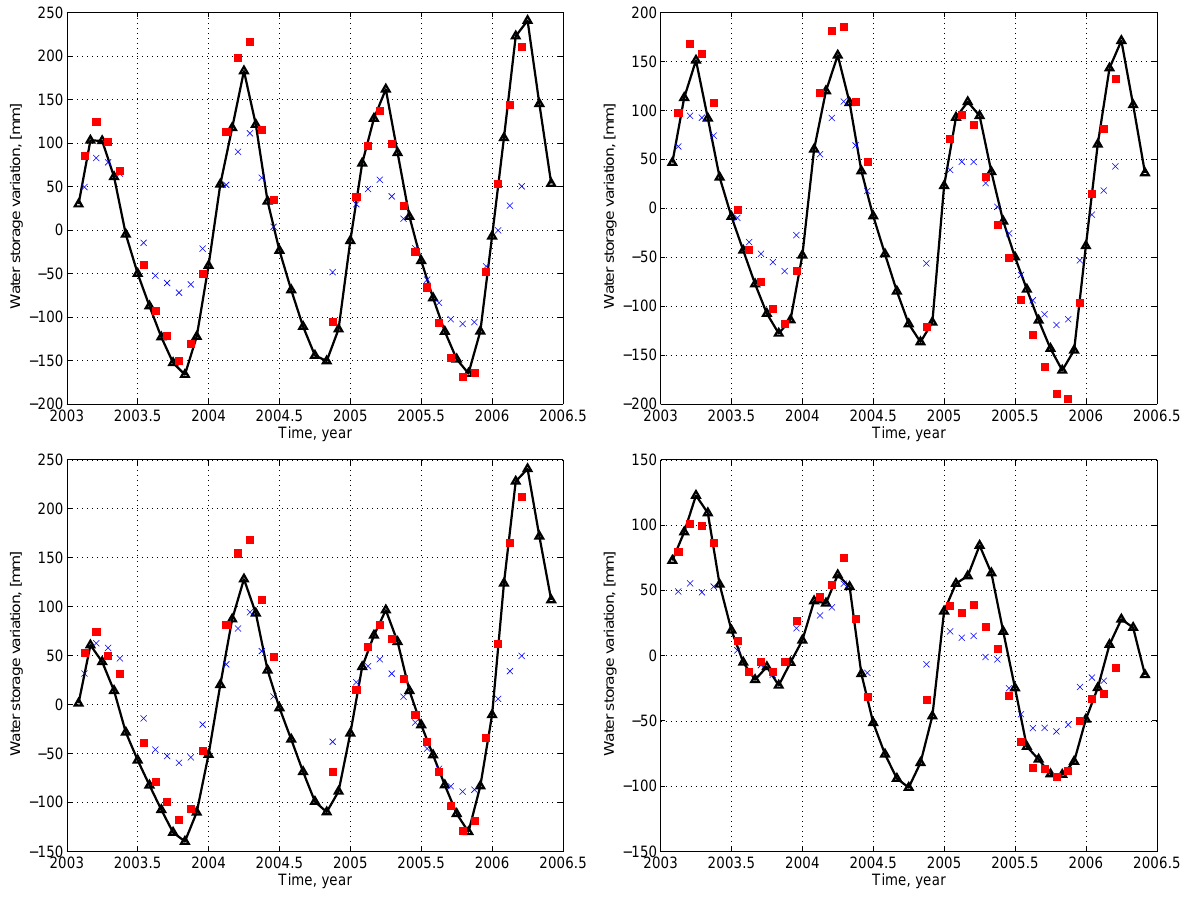
Fig. 5. Time series of monthly mean water storage variations over the target areas: From left to right and top to bottom: upper Zambezi, Zambezi, upper Zambezi + Okavango, and Zambezi + Congo. A 1000km Gaussian filter has been used. Black triangles: unfiltered LEW; blue x-marks: biased GRACE; red boxes: bias-corrected